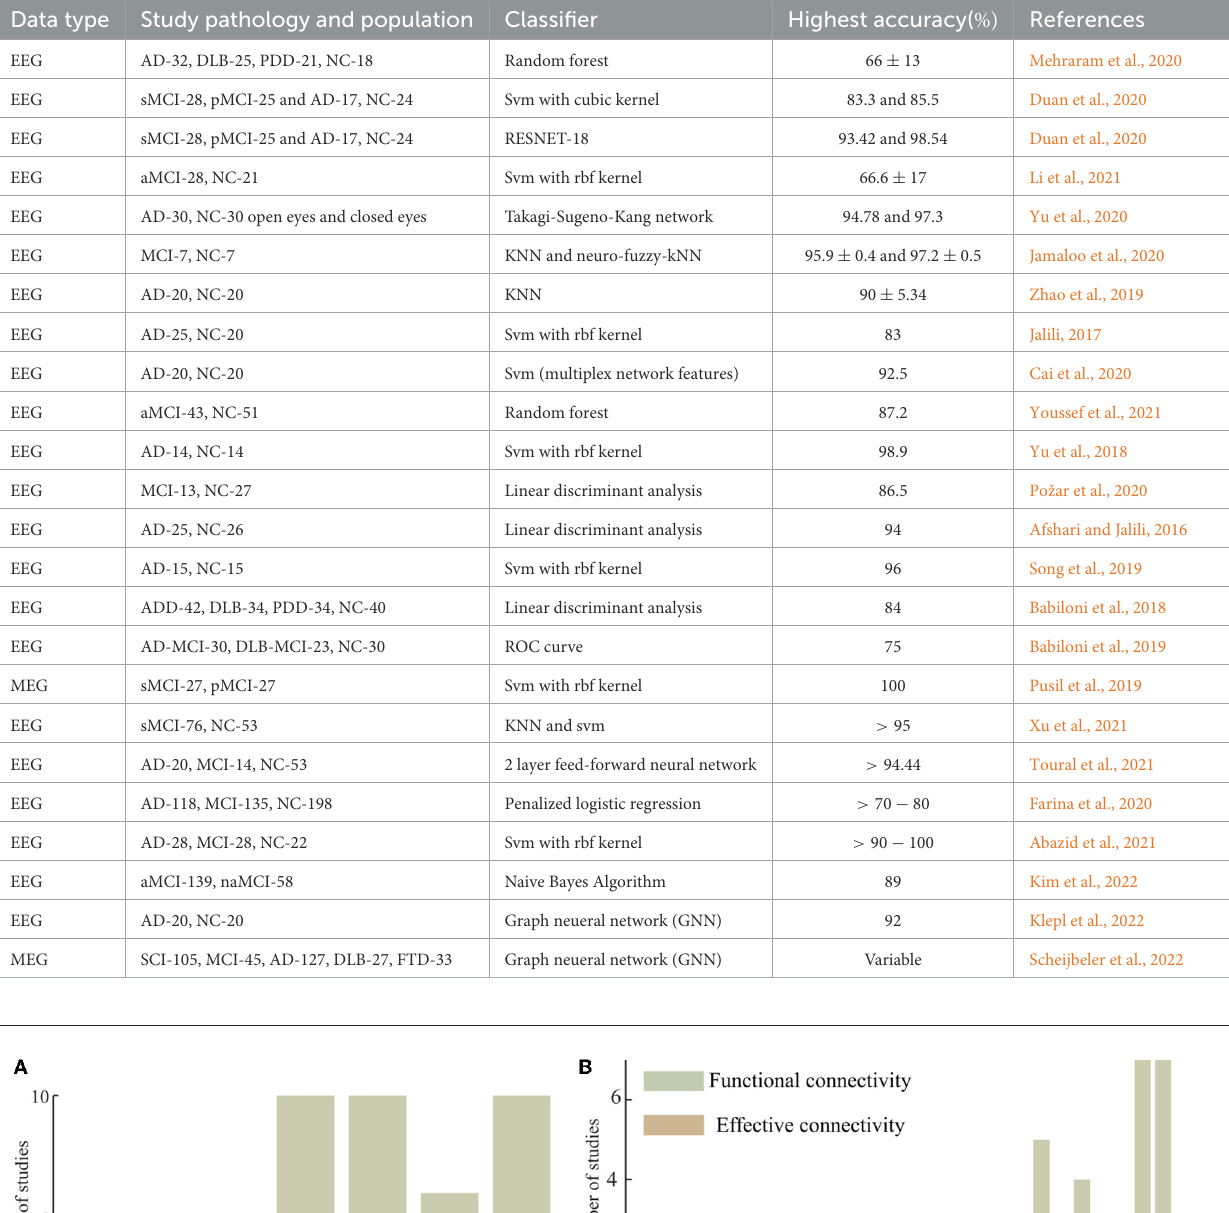
TABLE 3 Recent learning-based classification of dementia disorders using various functional connectivity features.